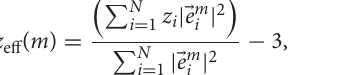
6 increases toward ∼